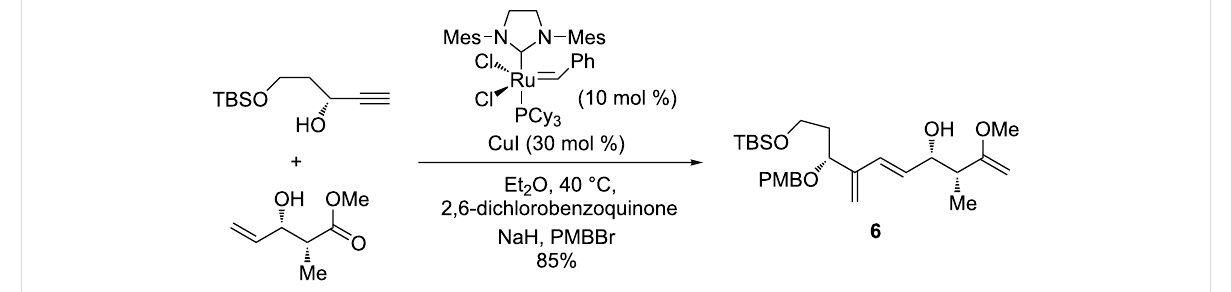
Scheme 9: Enyne metathesis between the propargylic derivative and the allylic alcohol in the synthesis of the southern fragment of des -epoxy- amphidinolide N.